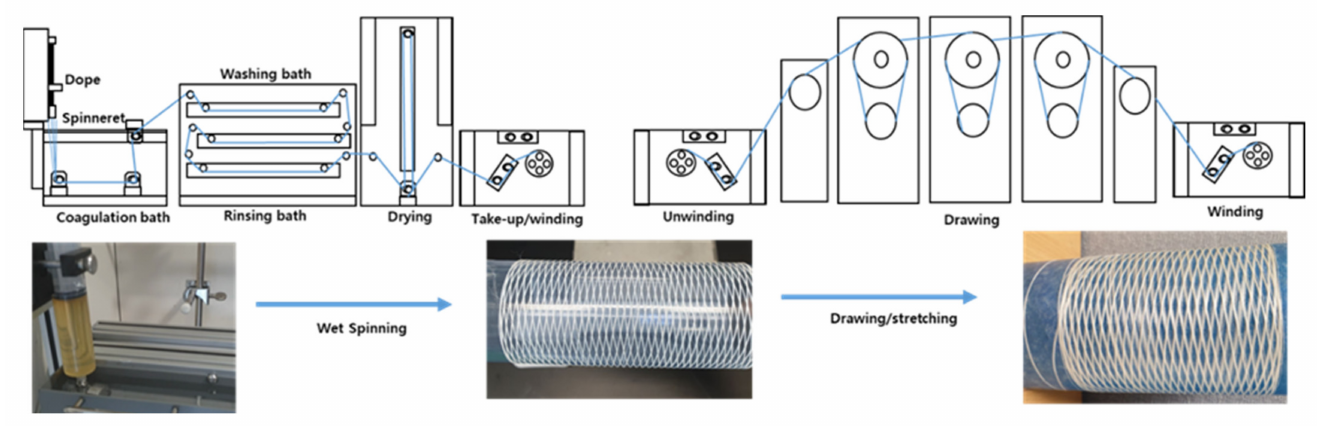
Figure 1. Schematic representation of the process of wet-spun PAN